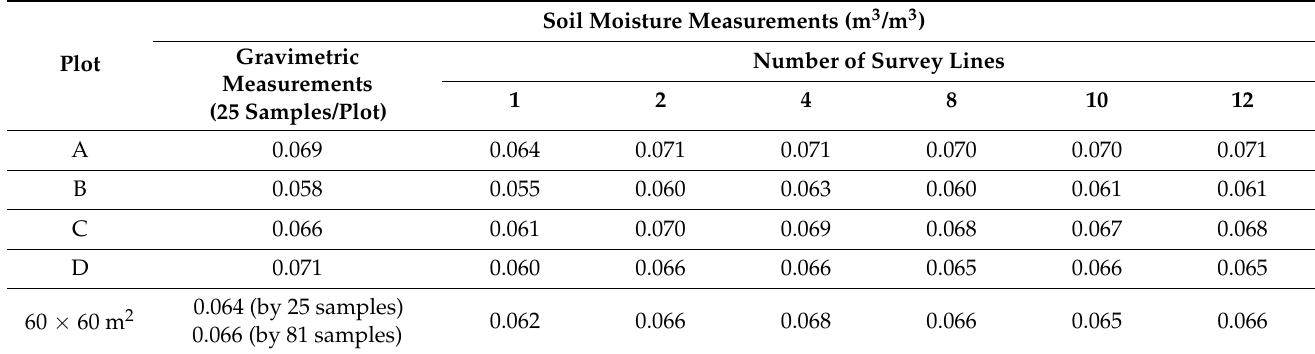
Table 3. Soil moisture measurements by gravimetric and GPR methods.